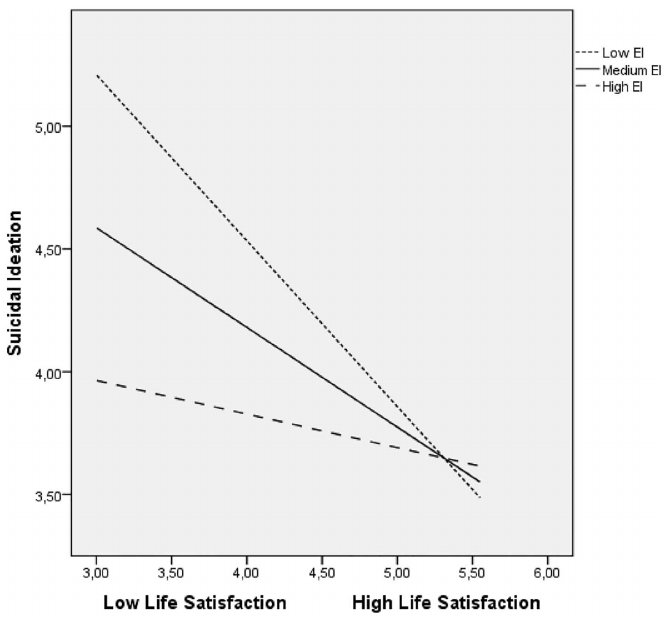
Fig 1. Relationship of life satisfaction and perceived EI for predicting suicidal ideation.